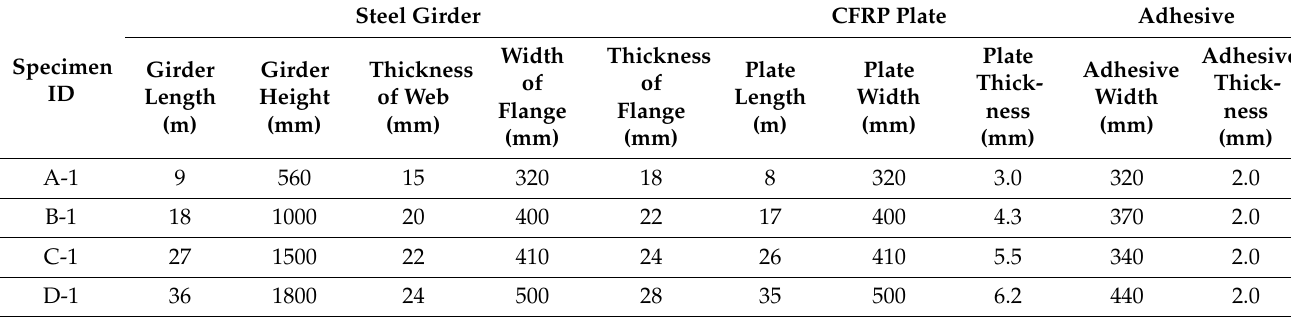
Table 1. The dimensions of specimens using Sika S512.